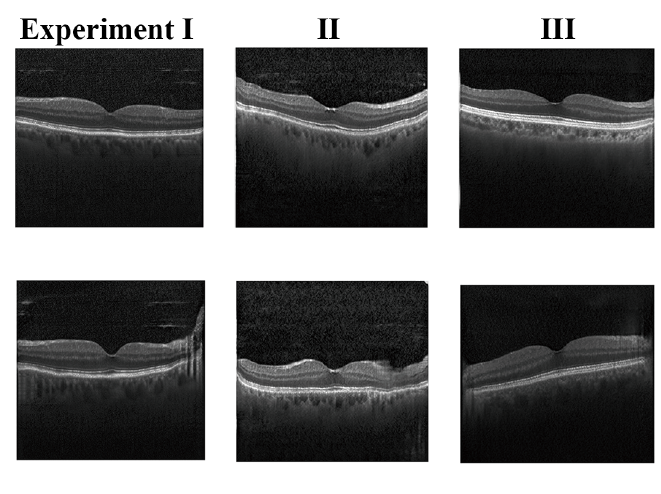
Figure 7. The three-step ablation experiment results. The images in the first column have some artifacts that could not be eliminated. The details in these images are deficient. The synthetic images in the second column are brighter and sharper, but reflect obvious mode collapse, with an increase in the FID. The images of Experiment III are better than Experiments I and II.